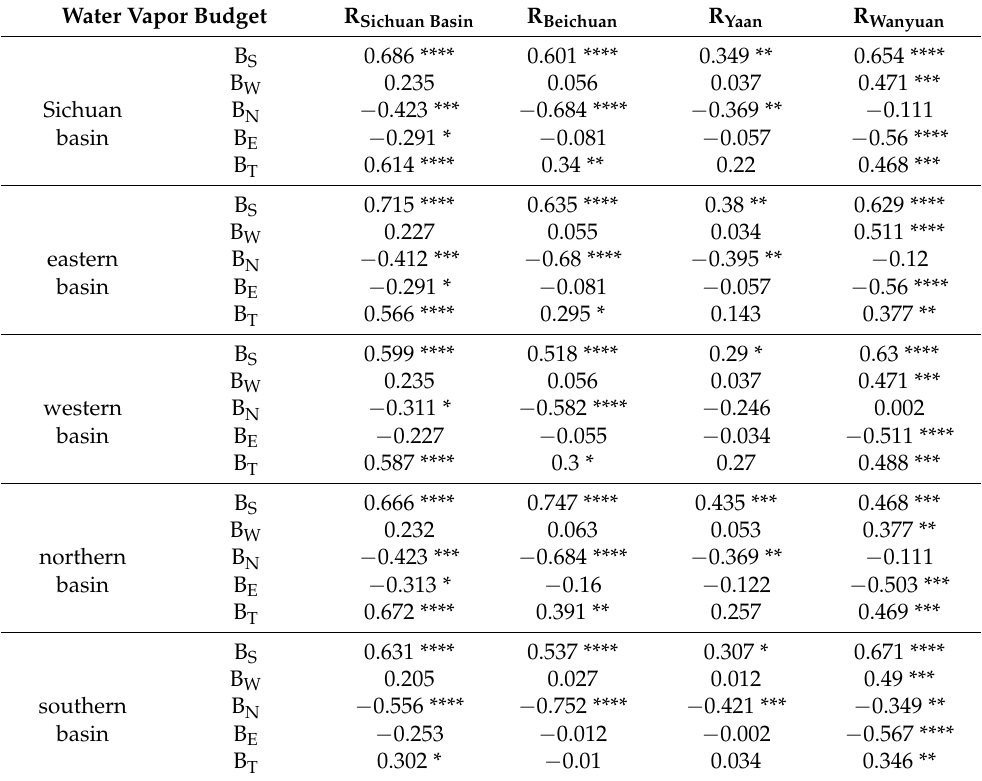
Table 2. Correlation Coefficients of the summer precipitation in the Sichuan Basin and at the three precipitation centers with the water vapor budget in the same period from 1979 to 2016. (**** represents passing the 99.9% confidence level, *** represents passing the 99% confidence level, ** represents passing the 95% confidence level, and * represents passing the 90% confidence